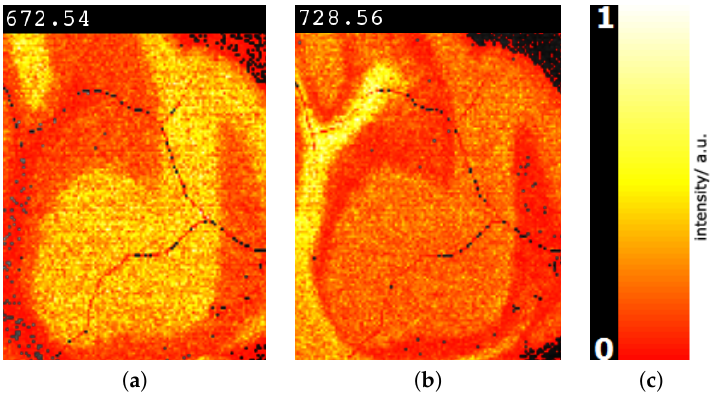
Figure 15. Image-space visualization of mouse cerebellum in positive ion mode data set [9] for peaks with m / z -ratios 672.54 ( a ) and 728.57 ( b ) selected in Figure 14. Multi-hue luminance color map ( c ) exhibits spatial intensity